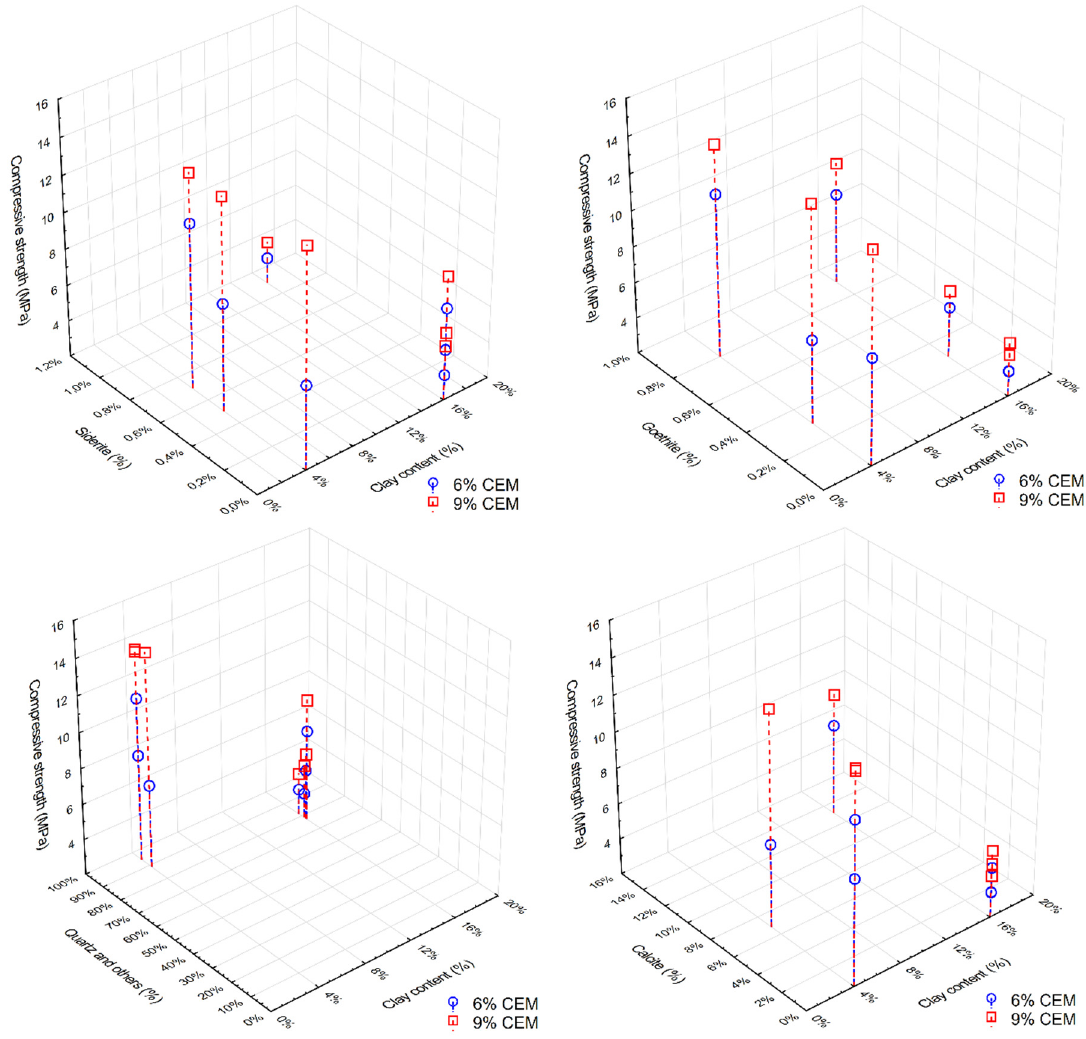
Figure 11. CSRE compression strength in comparison to the clay fraction content and on the amount of certain non-silicate minerals: goethite (top left), siderite (top right), quartz (bottom left), calcite (bottom right).